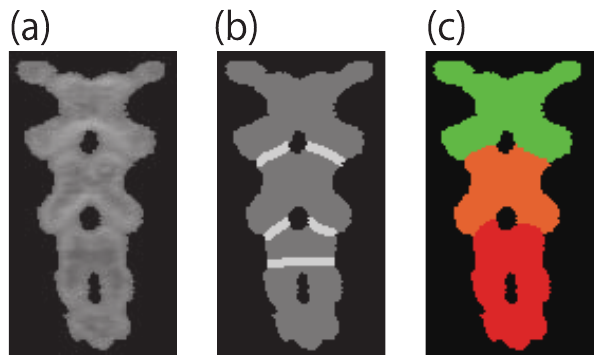
Figure 9. Backbone of a mouse (a) is the input CT image. The white areas in (b) are the ROIs. (c) is the result of the proposal